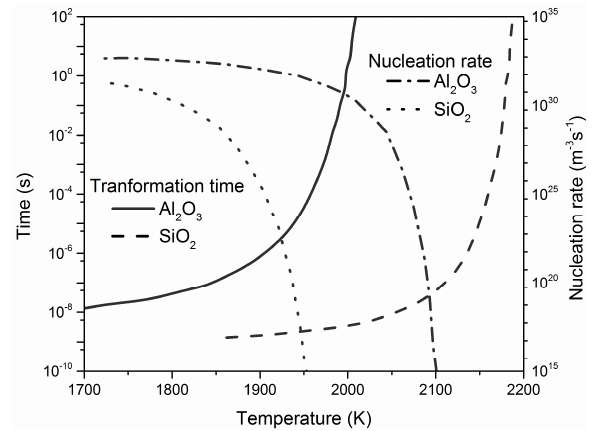
Figure 7. Time–Temperature–Transformation (TTT) curves of Al 2 O 3 and SiO 2 with transformation extent ζ = 0.9 and nucleation rates of Al 2 O 3 and SiO 2 [41].